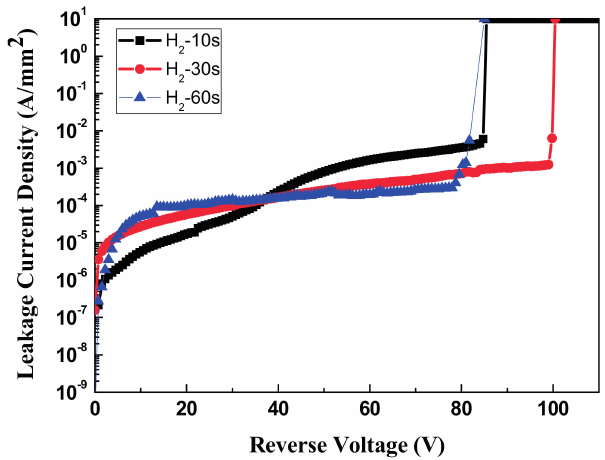
Figure 7. The J–V figure of 10 s/30 s/60 s H 2 plasma treated on Si substrate presented the SBDs breakdown voltage of 85 v/100 v/81